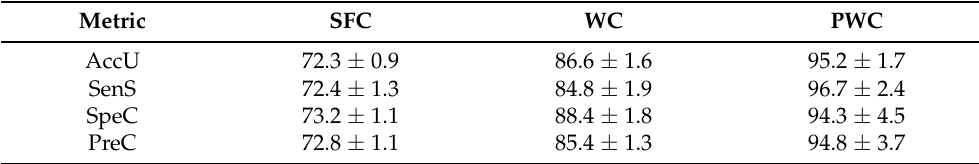
Figure 7. Classification accuracy (%) of 3L-CNN using PWC images reconstructed using first principal component through the first ten principal components. When using WC without application of SVD as input to the CNN, the classification accuracy of the 3L-CNN is 86.6%, as listed in Table 4. Table 4. Percentage of average AccU, SenS, SpeC and PreC ( ± standard deviation) of the 3L-CNN using SFC, WC and PWC images based on 10-fold CV